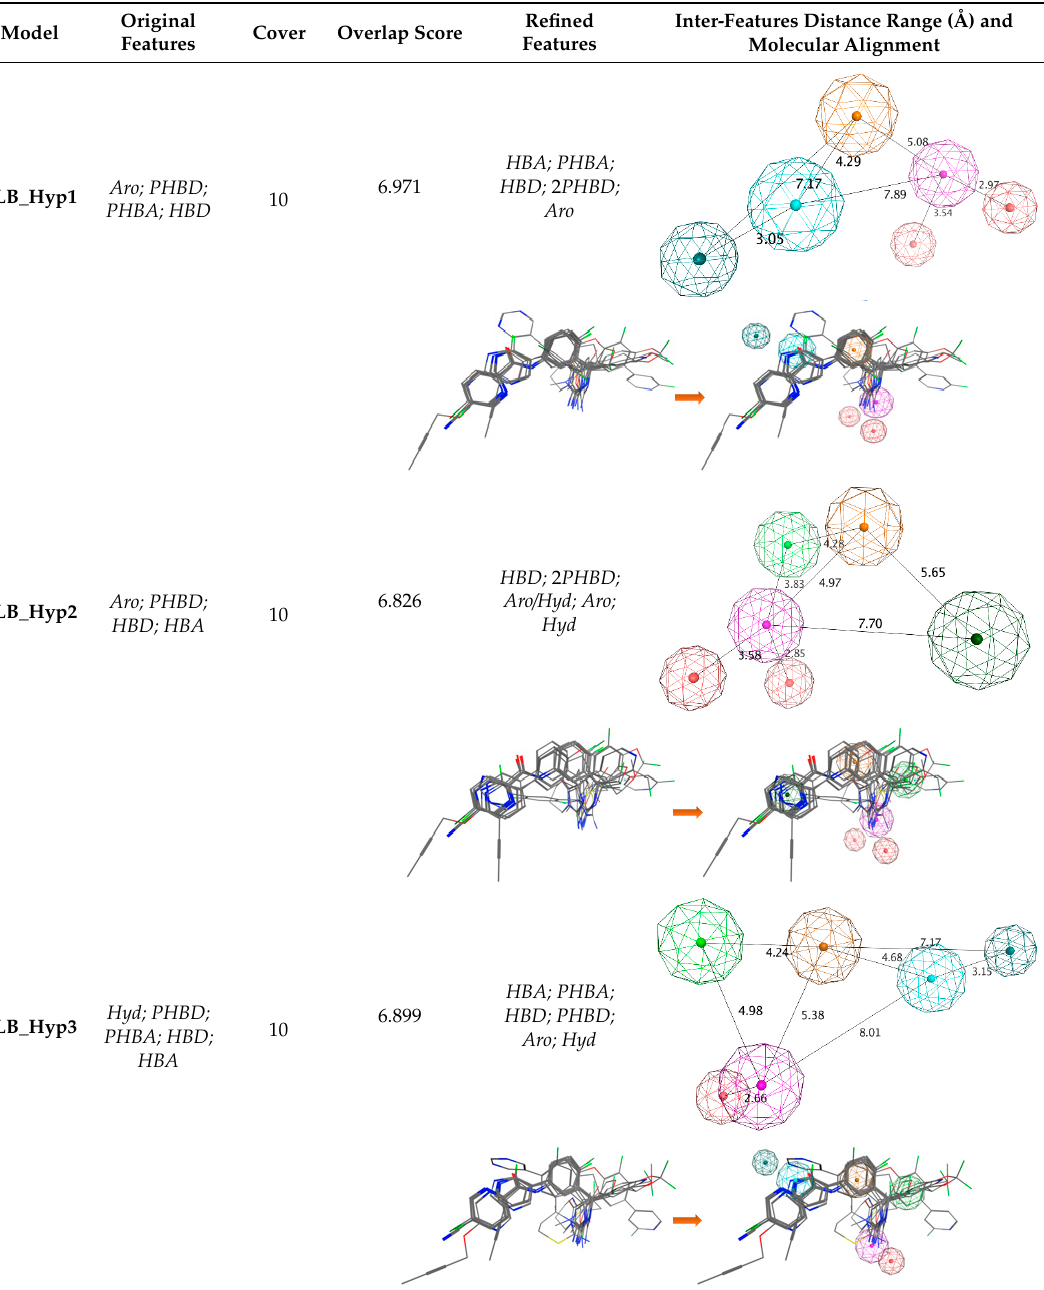
Table 2. Representation of LB (ligand-based) pharmacophoric hypotheses and their inter-feature distances. The alignment of multiple structurally di ff erent BACE1 inhibitors, the resulting pharmacophore features overlaid and the final derived pharmacophore are shown. The feature with the Cyan color indicates HBA ; the dark blue sphere represents projection of hydrogen bond acceptor ( PHBA ); magenta color shows HBD ; dark magenta color represents PHBD ; orange color indicates Aro ; green color represents Hyd ; and dark green color denotes aromatic or hydrophobic center ( Aro / Hyd ). LB_Hyp1 and LB_Hyp3 were obtained from the Elucidate_1 strategy and LB_Hyp2 from the Elucidate_2